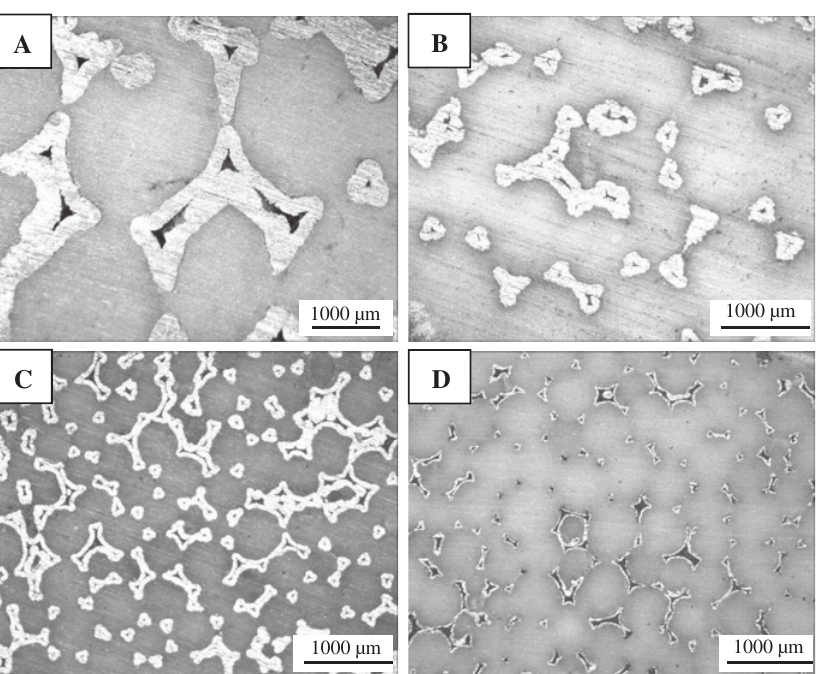
Figure 3: Morphologies of PEEK/Ni foam composites with Ni foams of different PPI values: (A) 25 PPI, (B) 50 PPI, (C) 100 PPI-1, and (D) 100